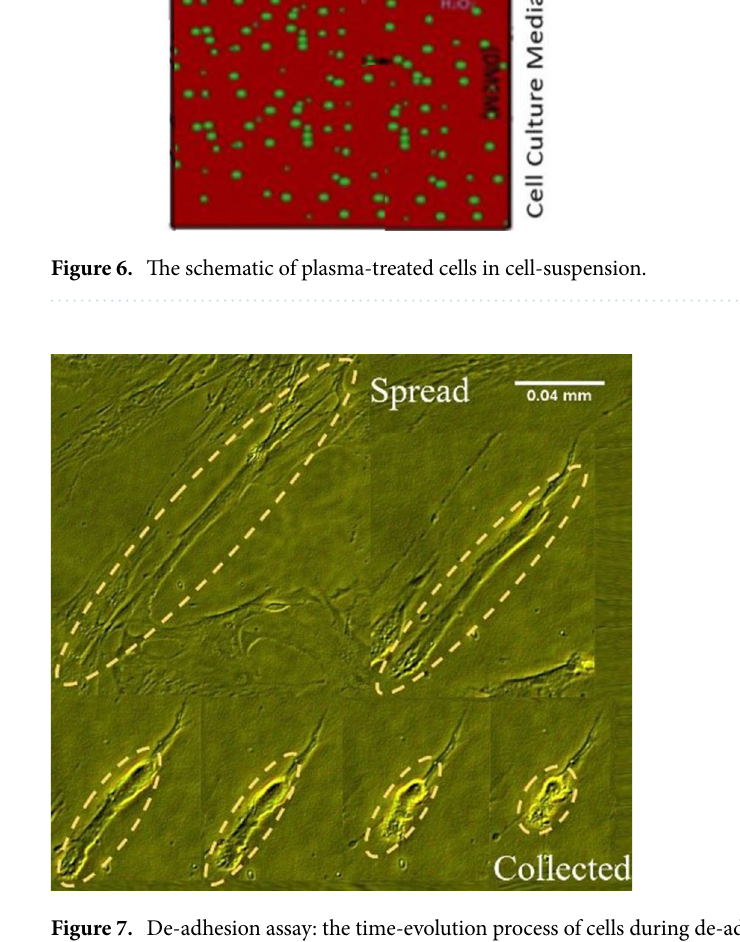
Figure 7. De-adhesion assay: the time-evolution process of cells during de-adhesion